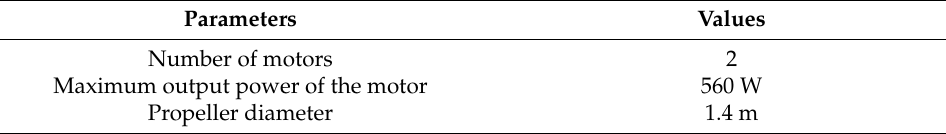
Table 5. Dynamic system parameters.